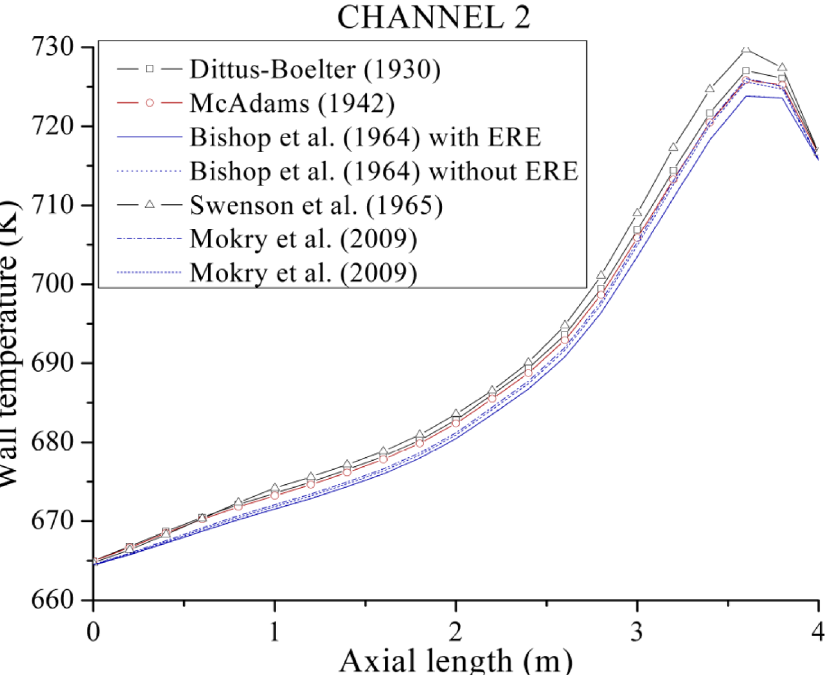
Fig. 9. Simulation results for Channel 2 showing the wall temperature behavior for different HTCs.